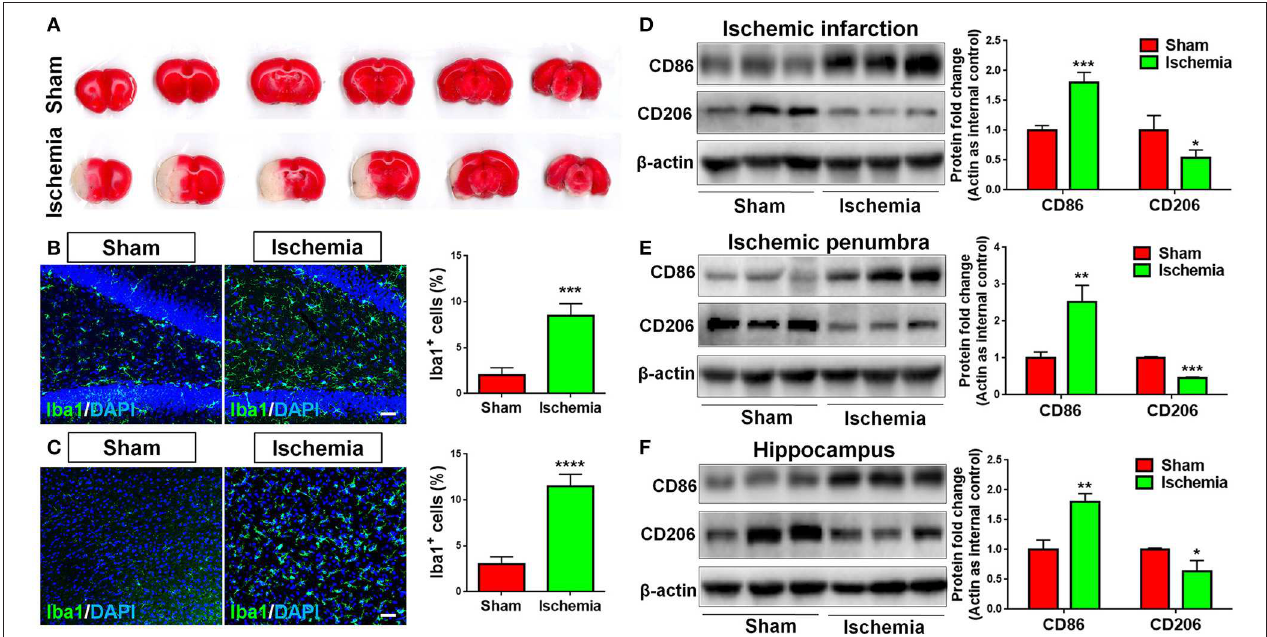
FIGURE 1 | Focal cerebral ischemia induces neuroinflammation. (A) Serial coronal slices of sham-operated and MCAO rat brains. TTC staining showed red healthy zones and pale infarcted regions. (B,C) Focal cerebral ischemic brains and their sham controls were removed after intracranial perfusion and prepared for immunofluorescence staining. Representative pictures of Iba1 immunoreactivities in the hippocampus (B) and cortex (C) of focal cerebral ischemic rat brain sections and control rat brain sections were shown. Proportions of cells with Iba1 immunoreactivities were given on the right panel. (D–F) Representative blot and quantification of CD86 and CD206 protein expression levels in ischemic infarction (D) , ischemic penumbra (E) , and hippocampus (F) . Scale bar: 20 µ m. Western blot data were normalized to β -actin and presented as fold change compared with those in sham rat brain. Error bars denote s.d. from triplicate measurements. * p < 0.05, ** p < 0.01, *** p < 0.001, and **** p < 0.0001 by two-tailed t -test ( n =